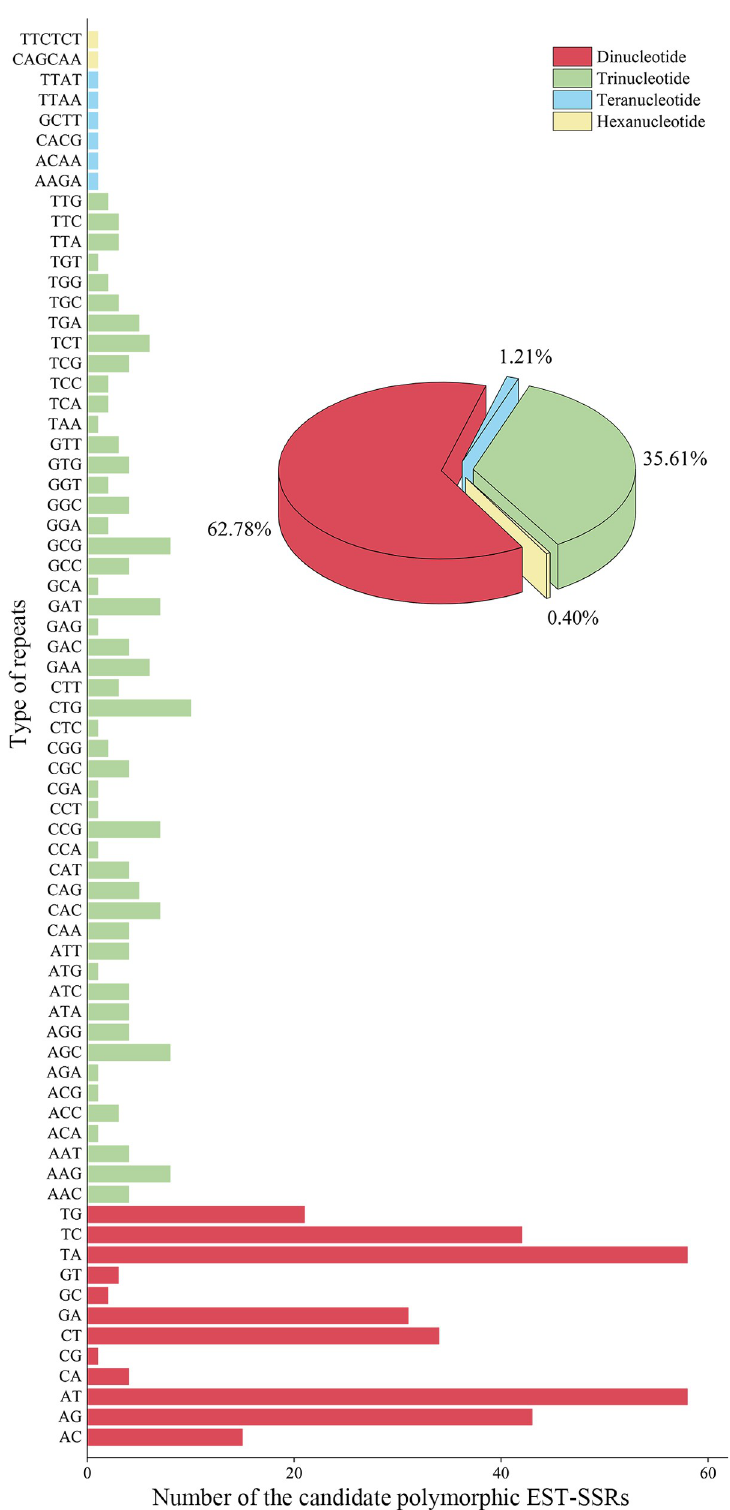
Fig 5. Frequency and distribution of candidate polymorphic EST-SSRs in the two Parrotia subaequalis transcriptomes.